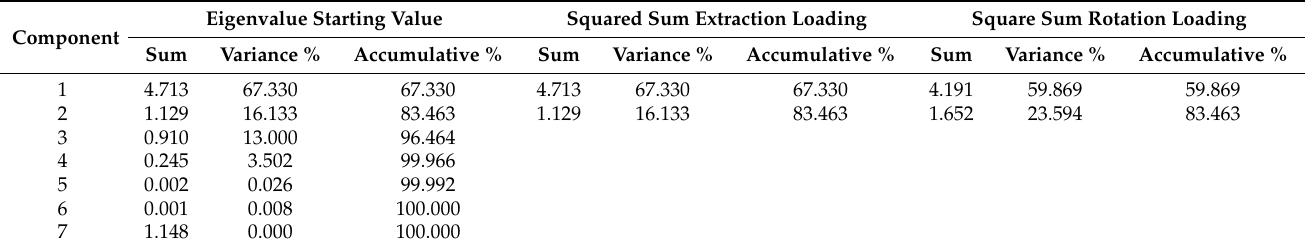
Table 11. Total interpretation variance.